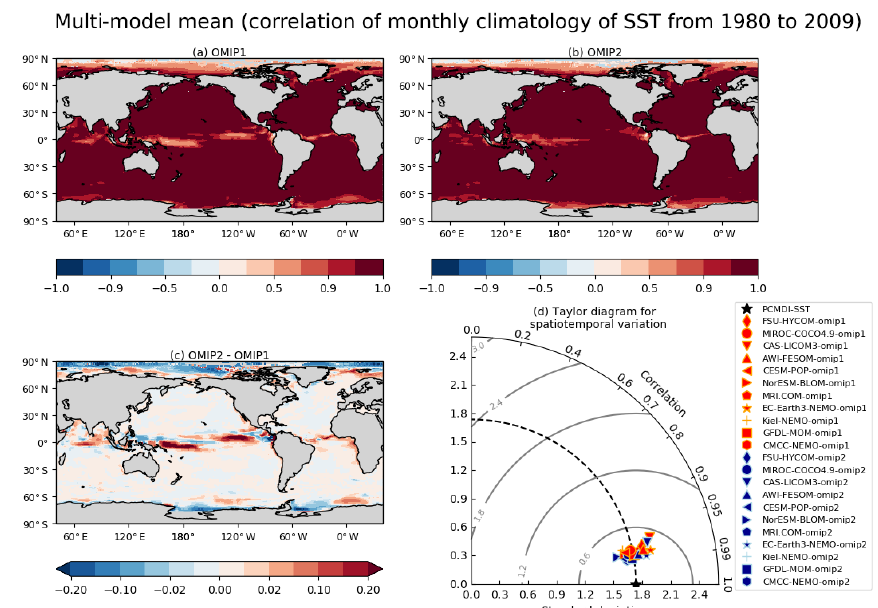
Figure E1. Multi-model mean correlation coefficients of monthly climatology of SST for the period 1980–2009 between simulation and PCMDI-SST. (a) OMIP-1, (b) OMIP-2, (c) OMIP-2 − OMIP-1. (d) Taylor diagram of the total space–time pattern variability of the monthly climatology of SST of OMIP-1 and OMIP-2 simulations relative to PCMDI-SST, with standard deviations expressed in units of ◦ C. For Figs. E1–E5, all models are used for multi-model mean. See Figs. S49–S51 for the results of individual models.